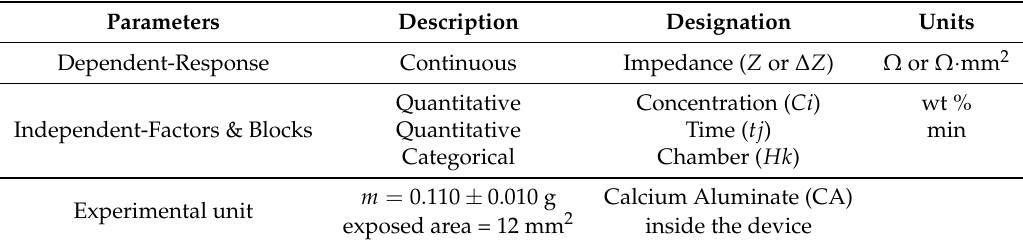
Table 4. Experimental parameters for device suitability